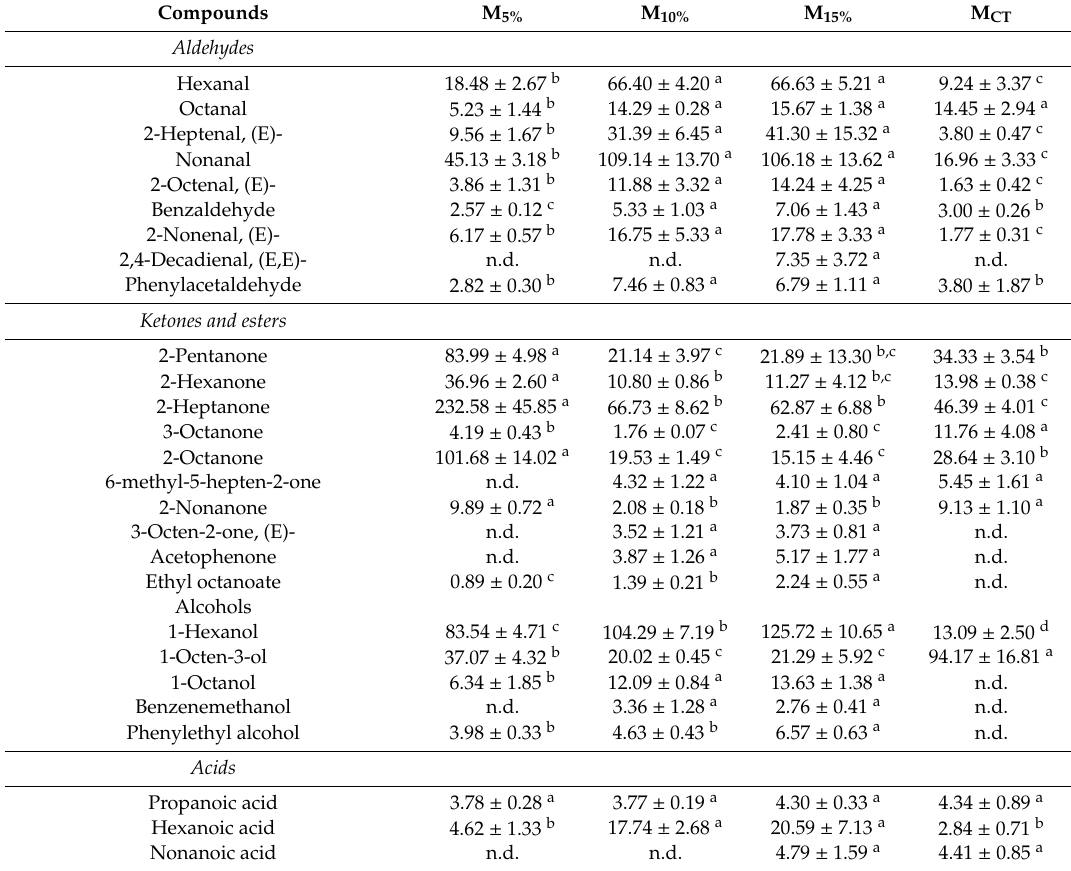
Table 4. Volatile organic compounds (expressed as µ g / g) of the te ff mu ffi ns M 5% , mu ffi n containing 5% (wt / wt) type-I sourdough; M 10% , mu ffi n containing 10% (wt / wt) type-I sourdough; M 15% , mu ffi